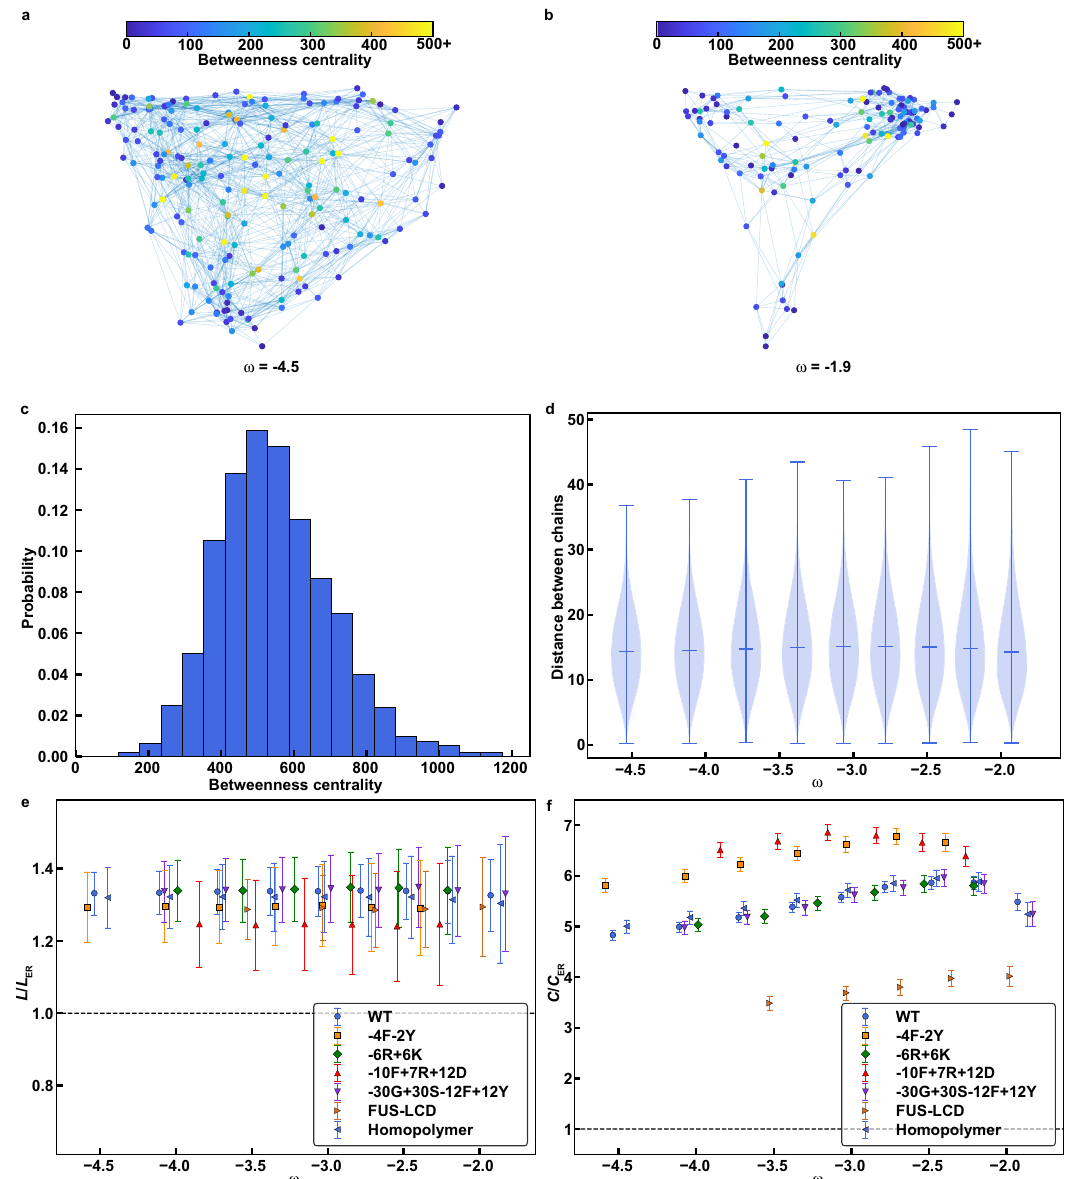
Fig. 3 | The interiors of condensates form small-world network structures. a , b Representative graphs for the largest connected cluster at the largest (a) and smallest (b) absolute value of ω (as de fi ned in Fig. 2). As ω approaches zero, the system approaches the critical point. Results are shown here from analyses of simulations for the wild-type A1-LCD. The nodes represent individual molecules and are colored according to their betweenness centralities as de fi ned in Eq. (2). Two chains are connectedby anundirectededge ifany two stickers between them ffiffiffi p are within 3 units on the cubic lattice. c The betweenness centrality distribution for chains with degree 24 at the lowest value of ω , − 4.5, for the WT A1-LCD. 920 samples were used to generate the distribution. d The pairwise distance dis- tributionsofthe5%ofchainswiththehighestbetweennesscentralitiesatvarious ω